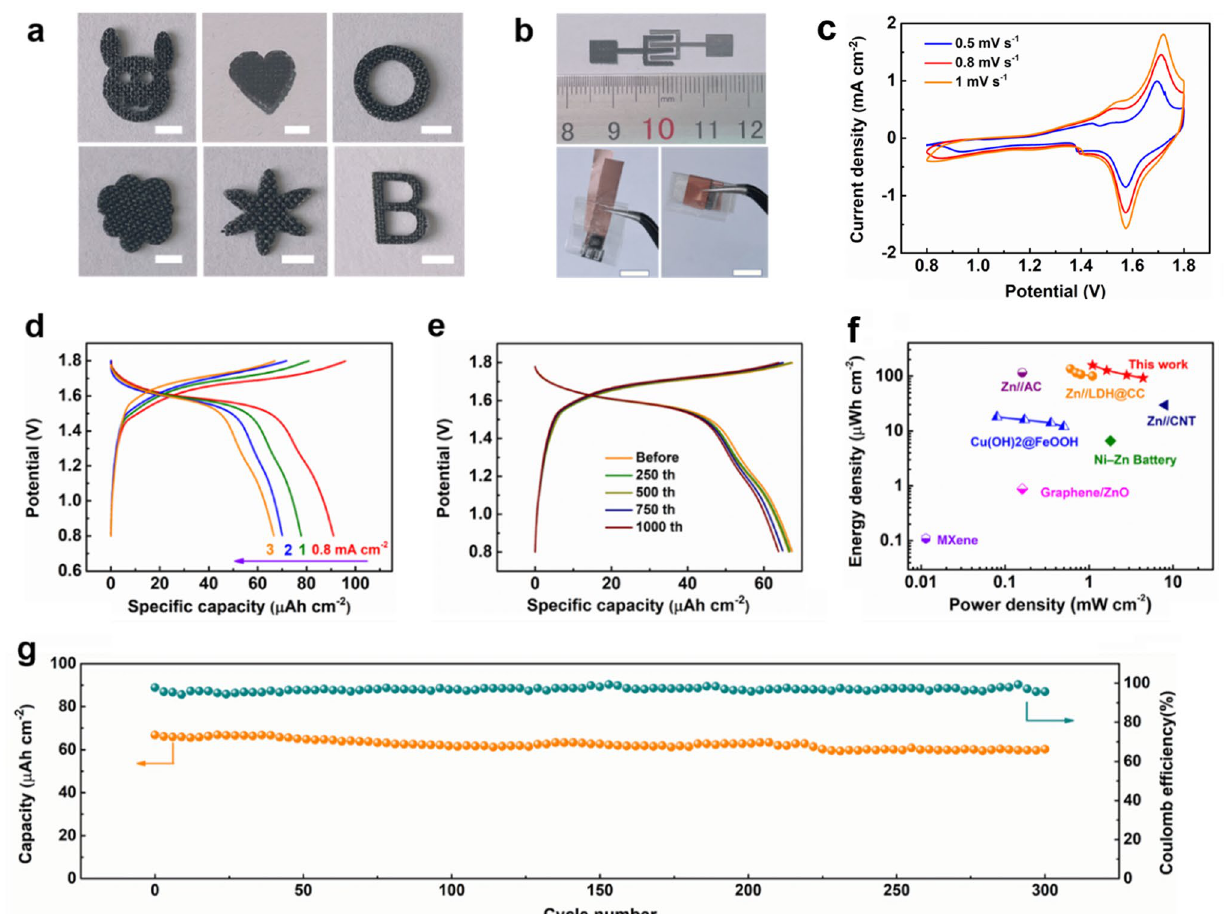
Fig. 6 Electrochemical performance of the assembled NC-ZMBs. a Illustration the machinability of the as-prepared samples, scale bar: 2 mm. b Digital photographs of different cropped patterns from NiCo LDH@CC, a single of NC-ZMBs and a single of NC-ZMBs with bending shape and a fully crimp state (scale bar is 1 cm). c, d CV curves and GCD curves of NC-ZMBs at different scan rates. e GCD curves of the NC-ZMBs with different bending cycles under the bending angle of 180°. f Ragone plots. g Long-term cycling